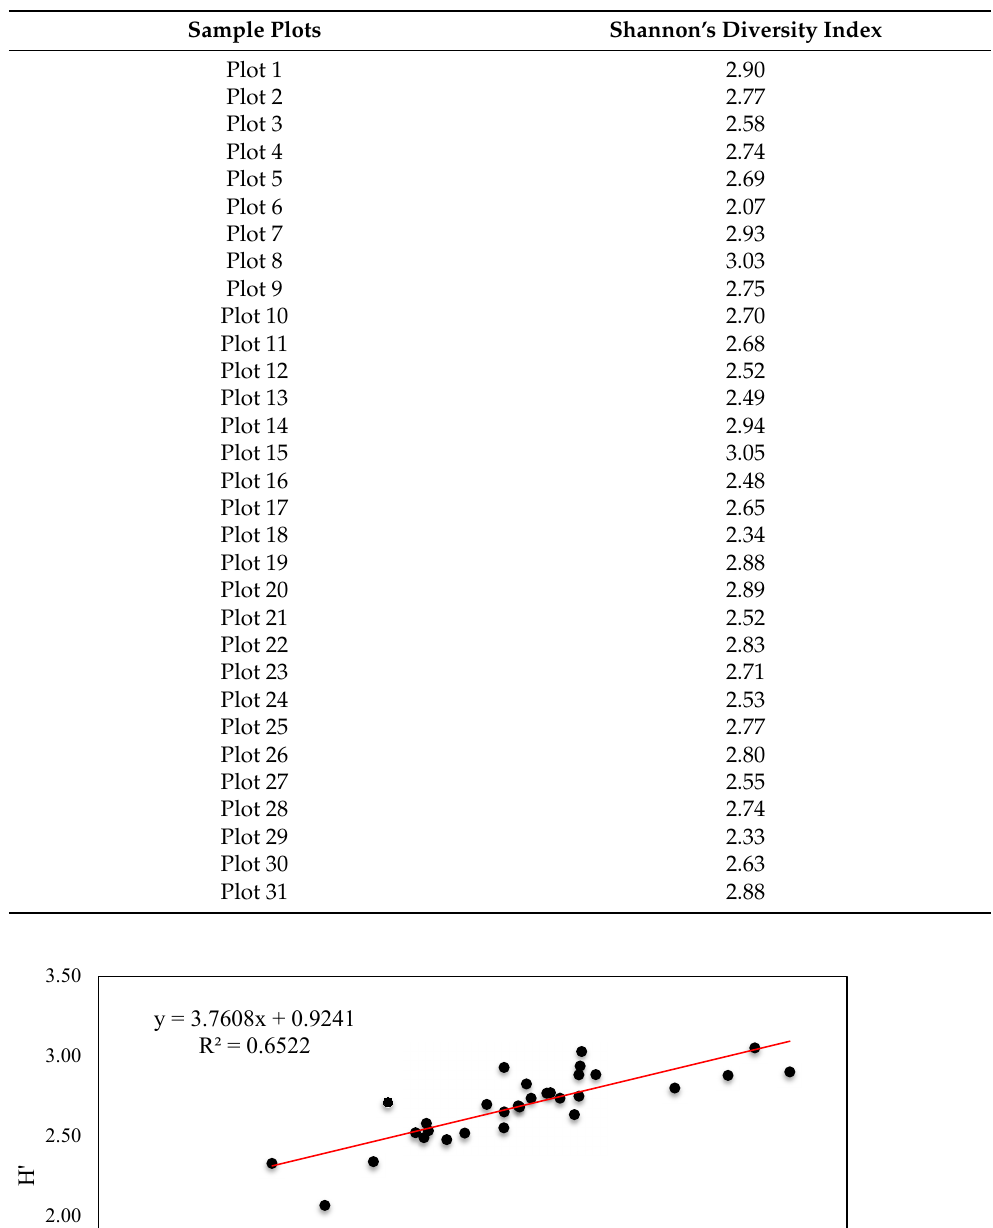
Table 8. Shannon’s Diversity Index Calculated from sample plots.